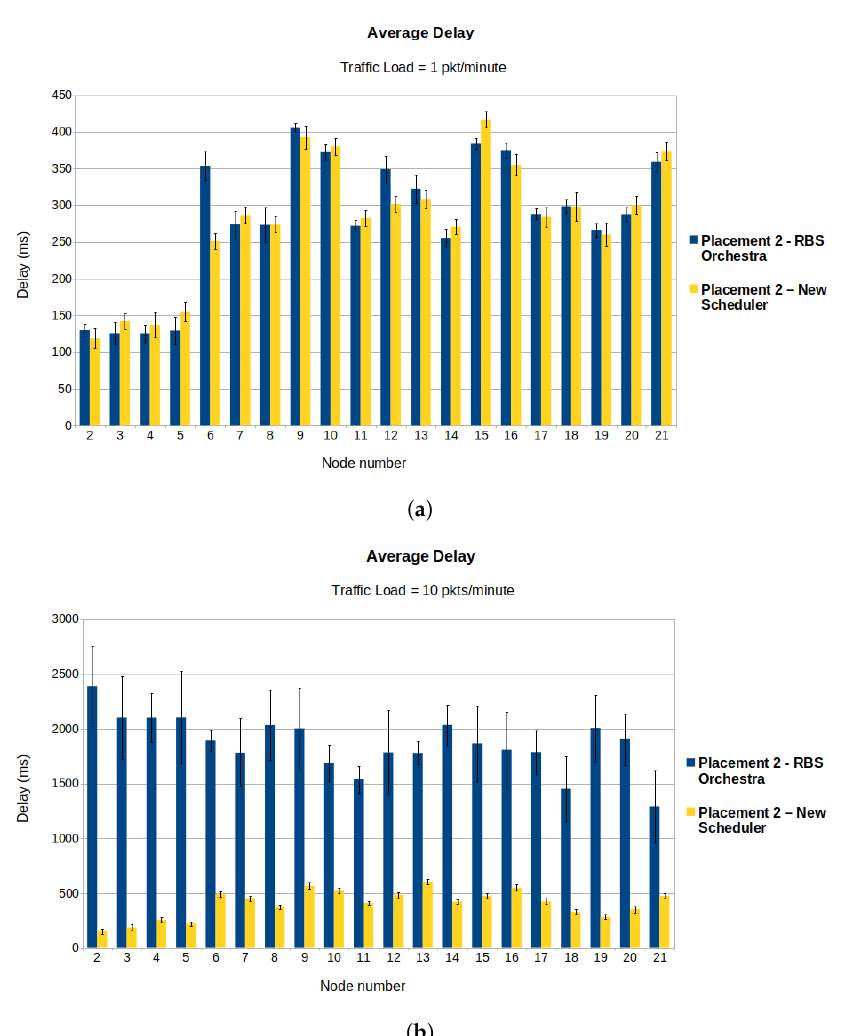
Figure 13. Average delay for each sender node in low and high traffic situations. ( a ) We observe that in normal traffic situation, the average delay is comparable for the two schedulers. ( b ) We observe that in high traffic situation for RBS Orchestra the average delay is highest for the root’s children, being nodes